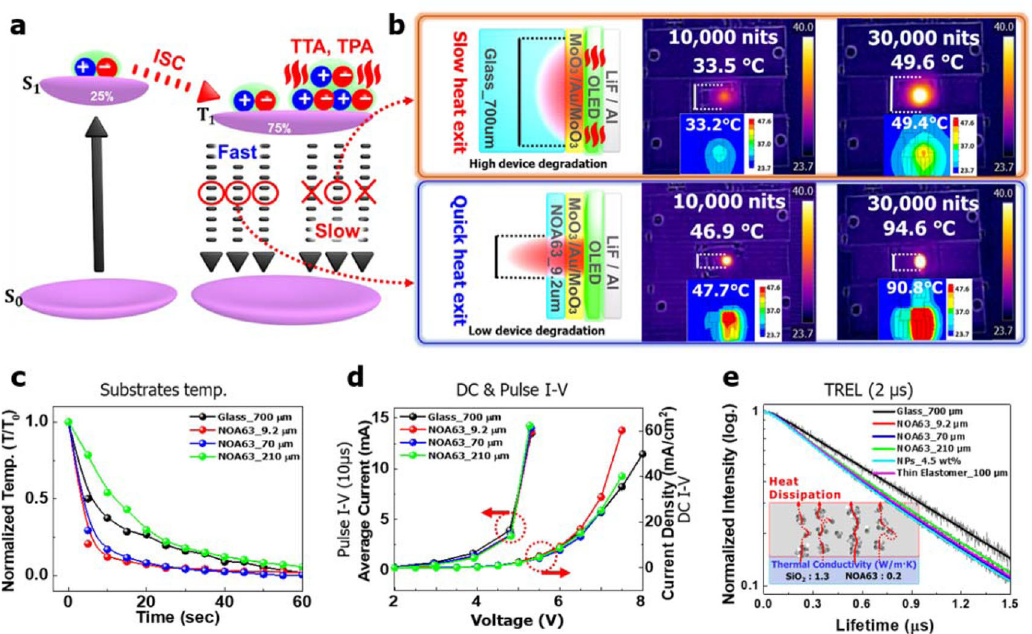
Fig. 5 Device performance of the MoO 3 /Au/MoO 3 (MAM) based GSOLED devices by heat dissipation mechanism. a The schematic illustration of the heat dissipation mechanism based on the triplet – triplet annihilation (TTA) and triplet-polaron annihilation (TPA) process b The schematic illustration, infrared (IR)-camera, and thermal simulation of heat accumulated and dissipated tendency in thin Norland Optical Adhesive 63 (NOA63) and thick glass substrate, which was con fi rmed by the temperature observance of the various substrate surfaces c The temperature drop rate curves with various substrates after the device is turned off. d The current density curve for pulsed I – V (W pulse = 10 µ s, duty cycle = 10%) and direct-current (DC) I – V characteristics of devices. e The time-resolved electroluminescence (TREL) decay pro fi les (thin gray lines) and their multi-exponential fi tting results (thick solid lines), which reveal that the exciton lifetimes of the EL devices can be gradually disturbed by adjusting their substrate thickness. Introducing nanoparticles (NPs) and a thin elastomer to the device also showed a similar effect. The inset of e describes the schematic illustration of metal oxide NPs clusters and porous scaffold